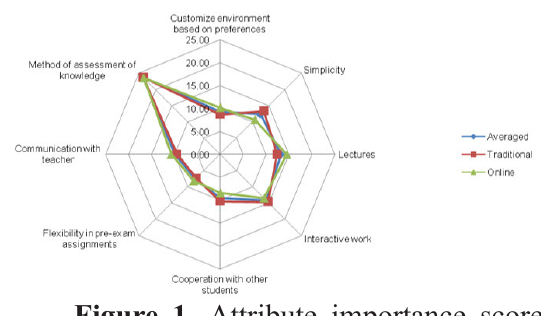
Figure 1. Attribute importance scores (%) for a priori defined segments Due to the limited sample size, two- and three-cluster solutions were analyzed. The 3-cluster solution was rejected because of small cluster (n < 10) that could not be statistically reliable. Accordingly, a 2-cluster solution was chosen and statistical significance of solution was confirmed by ANOVA (Table